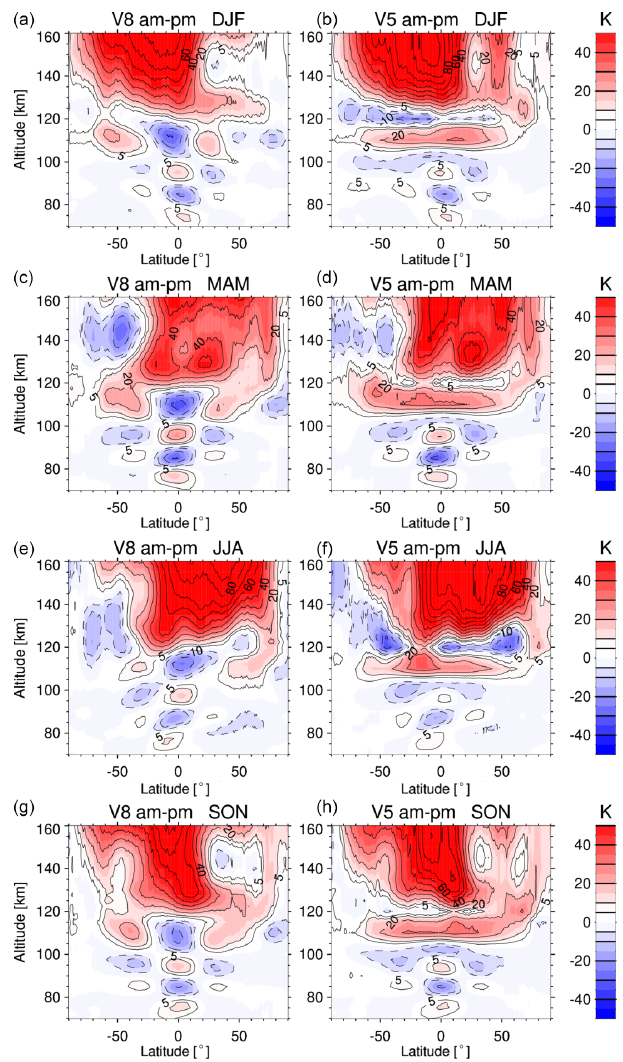
Figure 19. Seasonal composites of zonal mean temperature differ- ences between morning and afternoon observations of (left) version 8 and (right) version 5. Top to bottom: DJF, MAM, JJA,